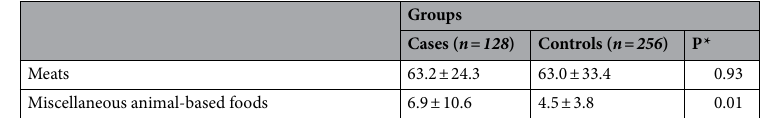
Table 1. Demographic characteristics, selected risk factors and dietary intakes of glioma cases and controls. All values are mean ± SD or percent. a Farmers were considered as having a high-risk occupation. b Subjects who lived in places nearby electromagnetic fields and cell phone and broadcast antennas in the last 10 years were considered as living in high-risk areas. c Subjects who consumed fried food, microwave and canned foods at least twice per week were considered as frequent users. *Obtained from independent-samples t-test or Chi- square test, where appropriate.